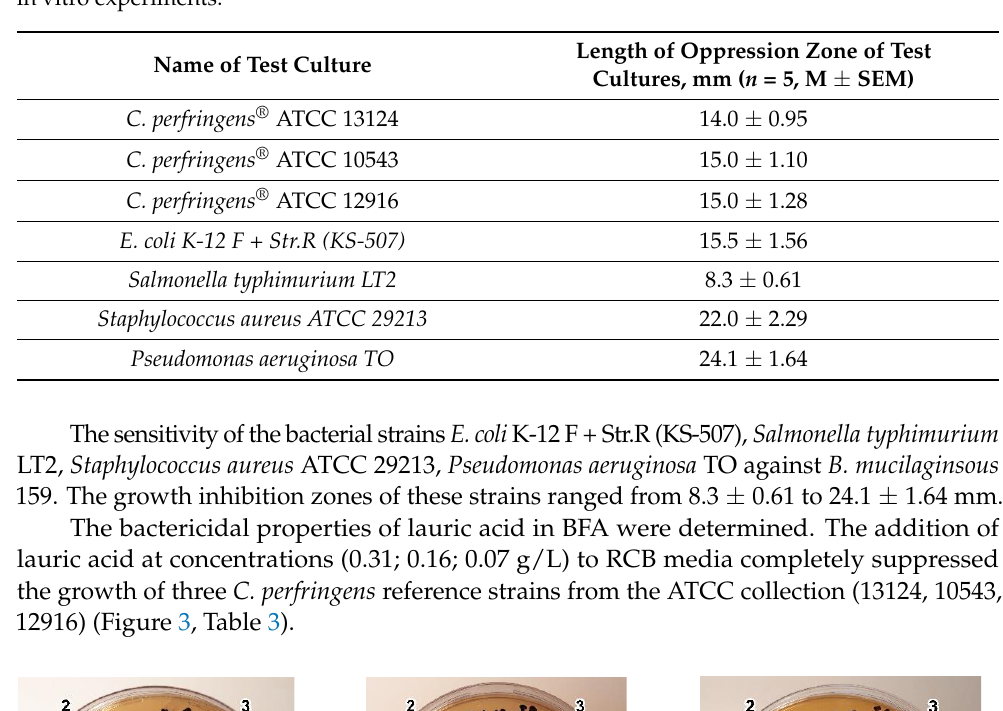
Figure 2. Antagonism of B. amyloliquefaciens 159 strain against toxin-producing strains in in vitro experiments ( A ) C. perfringens 10543, ( B ) C. perfringens 12916, ( C ) C. perfringens 13124, 1—growth zone of test microorganism, 2—growth inhibition zone of test microorganism, 3—growth zone of B. amyloliquefaciens 159. Table 2. Inhibition zones of test cultures influenced by strain B. amyloliquefaciens 159 in in vitro experiments.